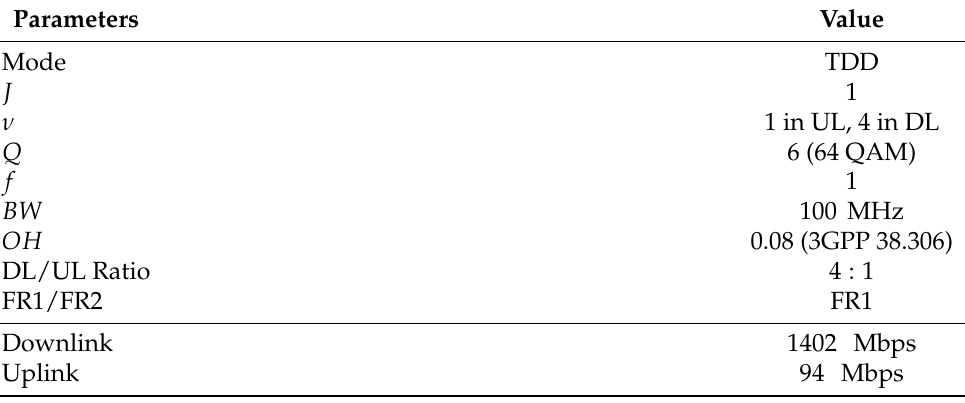
Table 1. Utilized 5G innovation network—cell throughput capacity. The values are selected according to the network’s and the UE’s hardware and